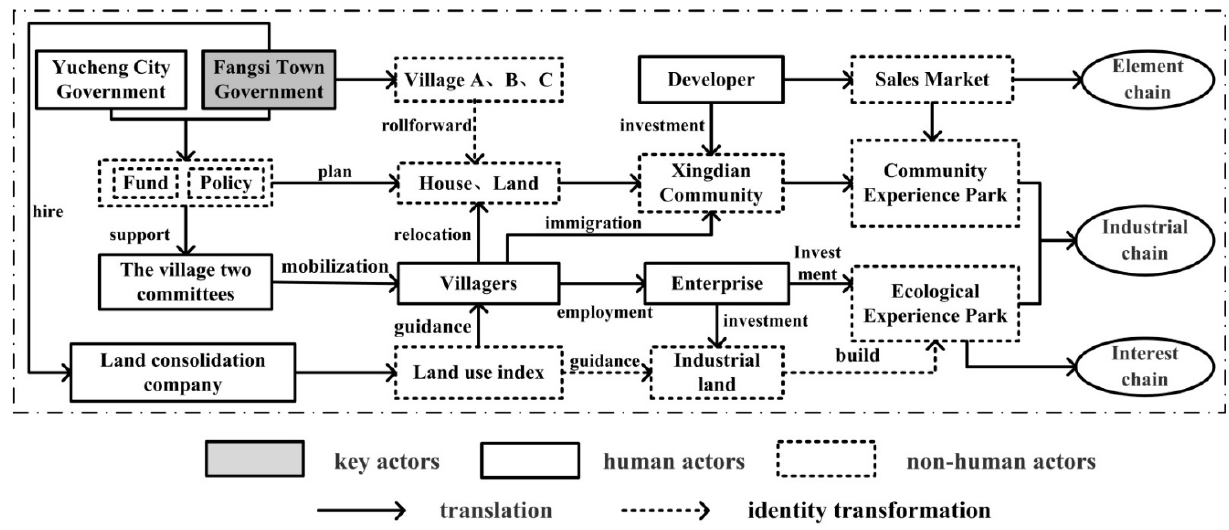
Figure 7. Action network of village integration–scale operation mode.